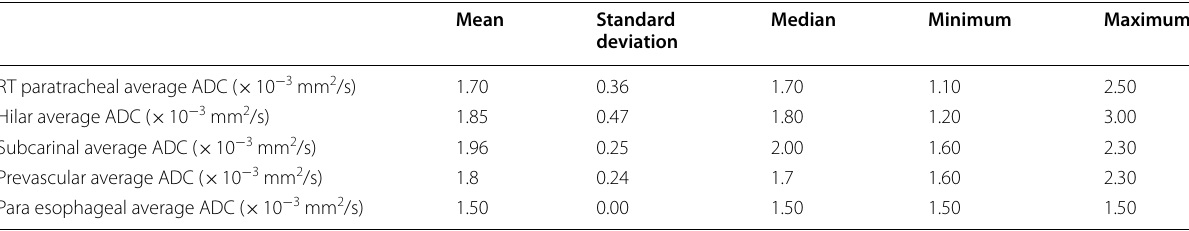
Table 3 ADC values for each lymph node group in sarcoid patients